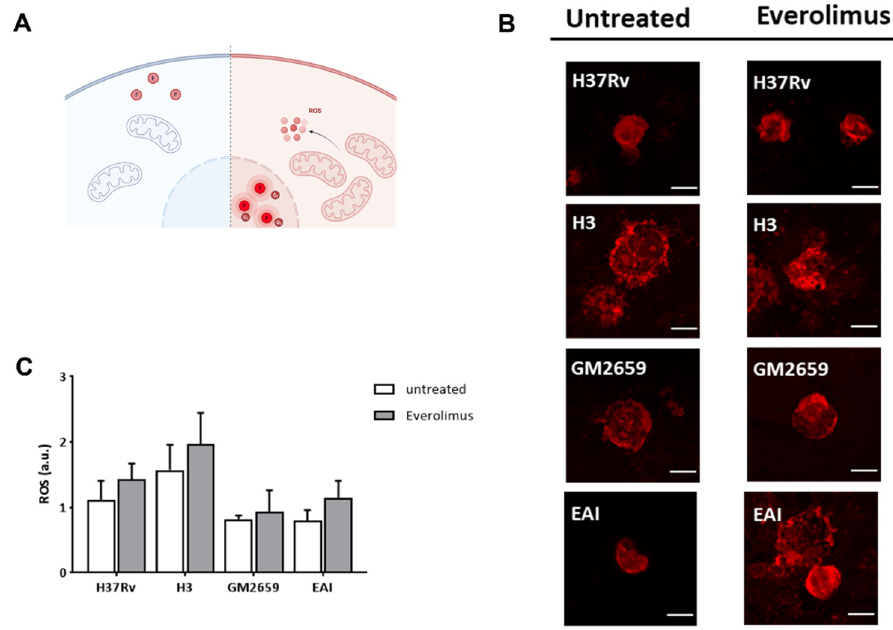
Figure 4. Schematic representation of the functioning of CellROX green reagent used to assess the impact of Everolimus on ROS production ( A ). CellROX reagent is non-fluorescent in a reduced state, while upon oxidation it binds to DNA principally in the nucleus and mitochondria, emitting a strong fluorogenic signal. Cells were treated with Everolimus M 8 ng/mL one hour post infection. Oxidative stress was assessed five hours post infection. Cells were fixed with PFA and then imaged with a confocal microscope ( B ). ROS production was quantified and represented as barplot ( C ). Data were analysed using two-way ANOVA with Bonferroni’s multiple-comparisons test. Everolimus-treated cells had higher levels of ROS, although this difference was not statistically significant.